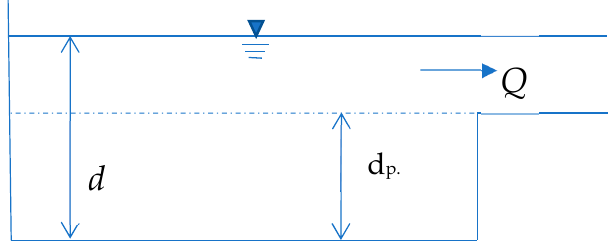
Figure 1. Slope confluence with water storage in depressions [19].